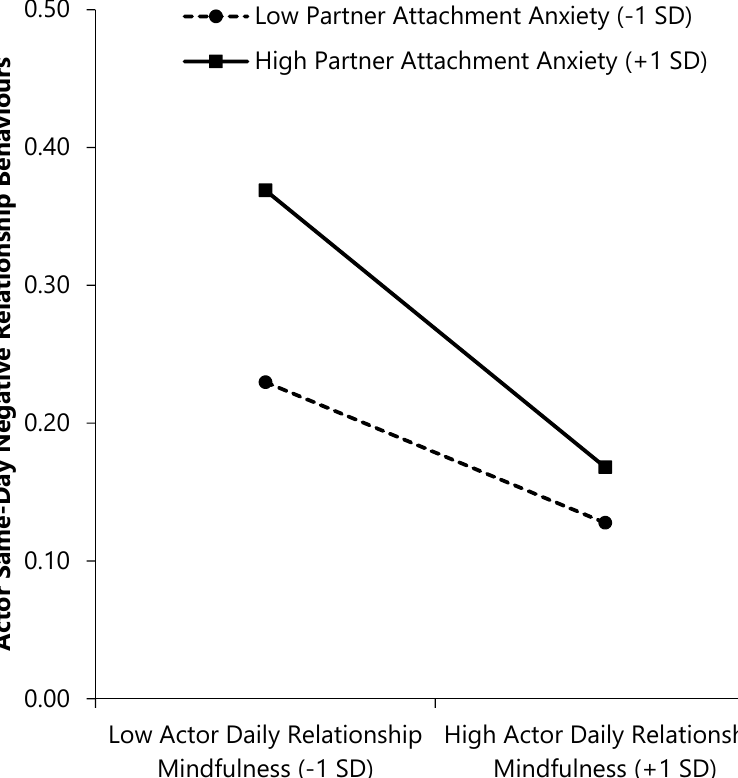
Figure 1. Interactions of attachment anxiety and daily relationship mindfulness with same-day negative relationship behaviours. Higher scores on continuous variables represent greater standing on the variable (e.g., higher daily relationship mindfulness (RM)).